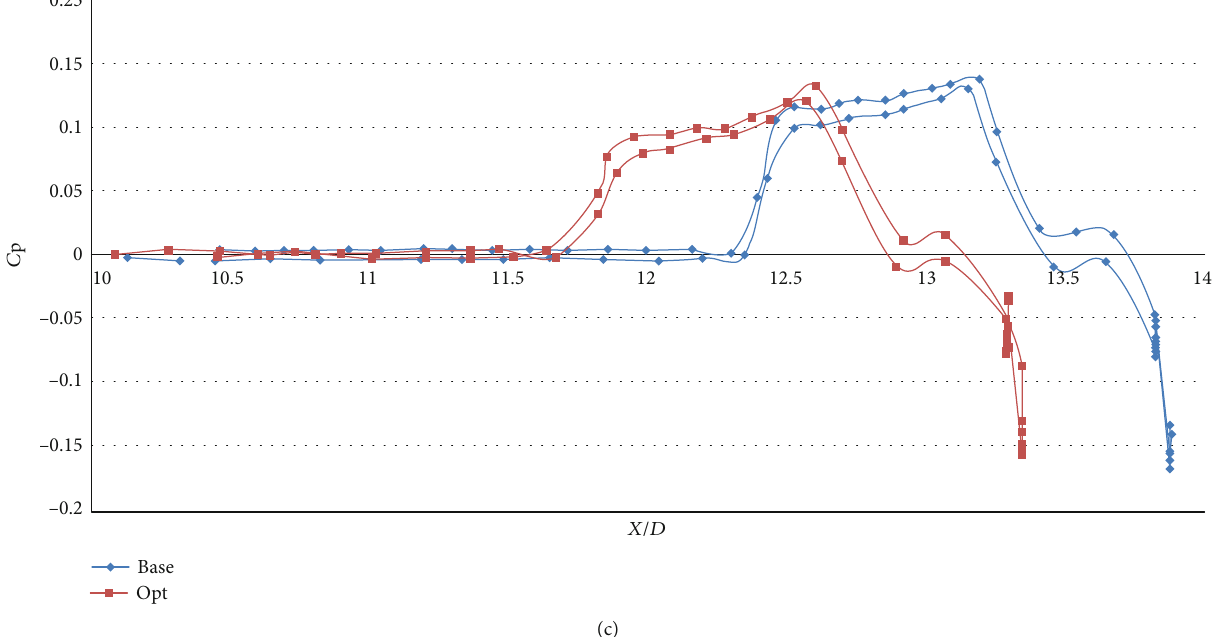
Figure 17: Pressure coe ffi cient distribution for the base and optimum missile fi n at 4 ° AoA: (a) Mach 1.4, (b) Mach 2, and (c) Mach